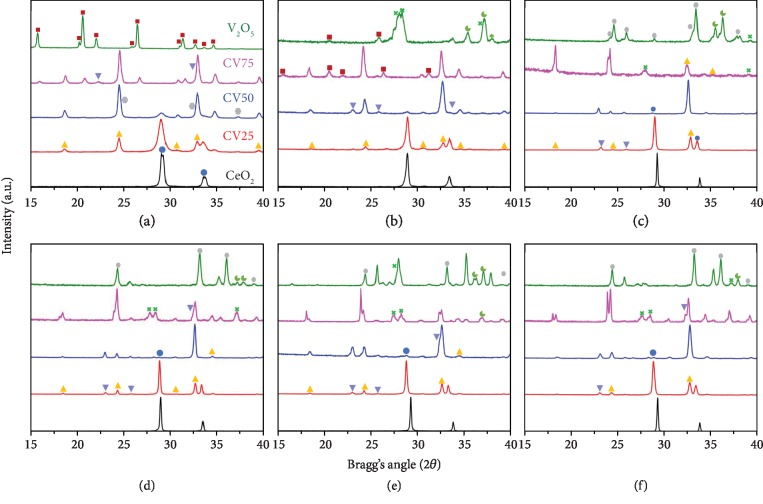
Structural analysis of vanadia–ceria systems: XRD patterns of (a) as-prepared and after cycled (b) reduced, (c) MPO–CDS, (d) MPO–WS, (e) MPO–WS–CDS, and (f) MPO–CDS–WS, pure ceria, CV25, CV50, CV75, and pure V2O5 representing the evolution of CeVO4 as a function of vanadium content and structural changes in after-cycling. Spheres, upward cones, hexagons, downward cones, squares, crosses, and crescents represent CeO2, CeVO4, V2O3, CeVO3, V2O5, VO2, and VC phases, respectively.